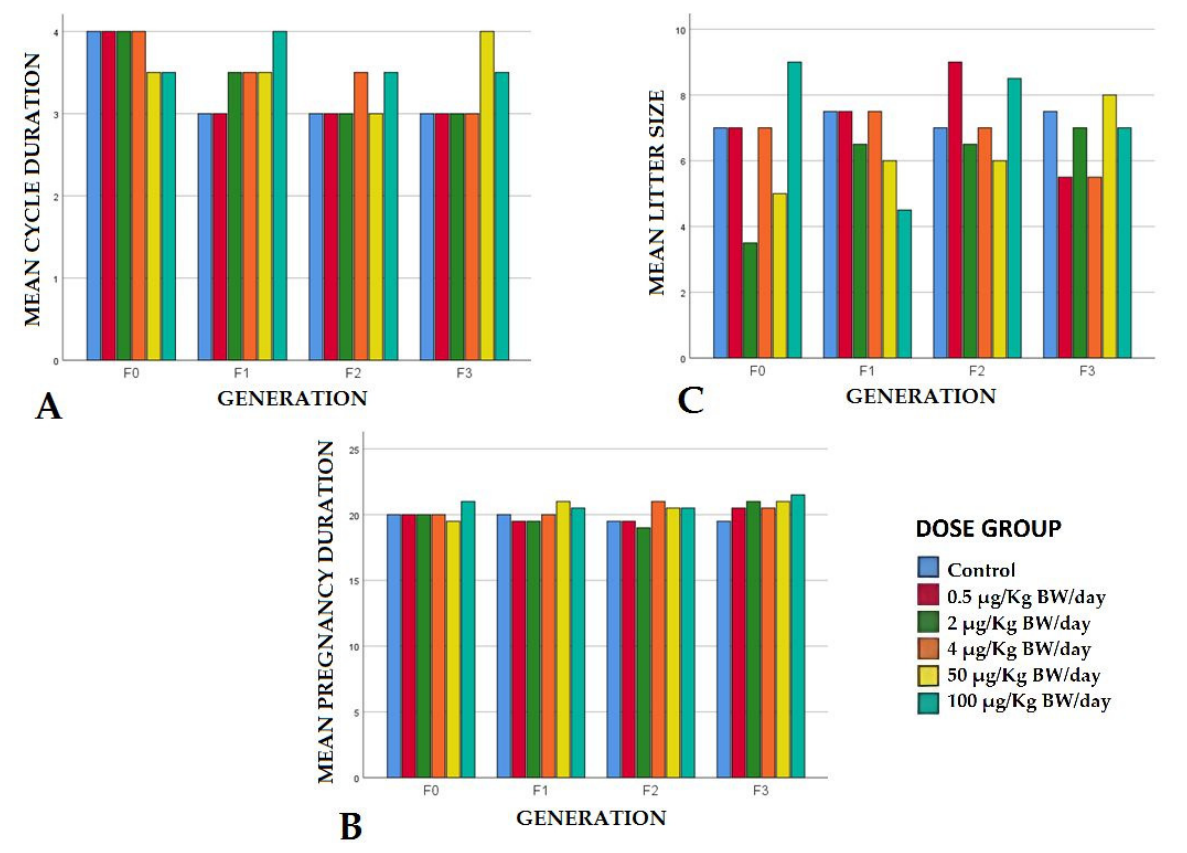
Figure 2. Mean reproductive parameter values per dose group and generation. ( A ) Cycle duration expressed in days; ( B ) Pregnancy duration expressed in days; ( C ) Litter size.